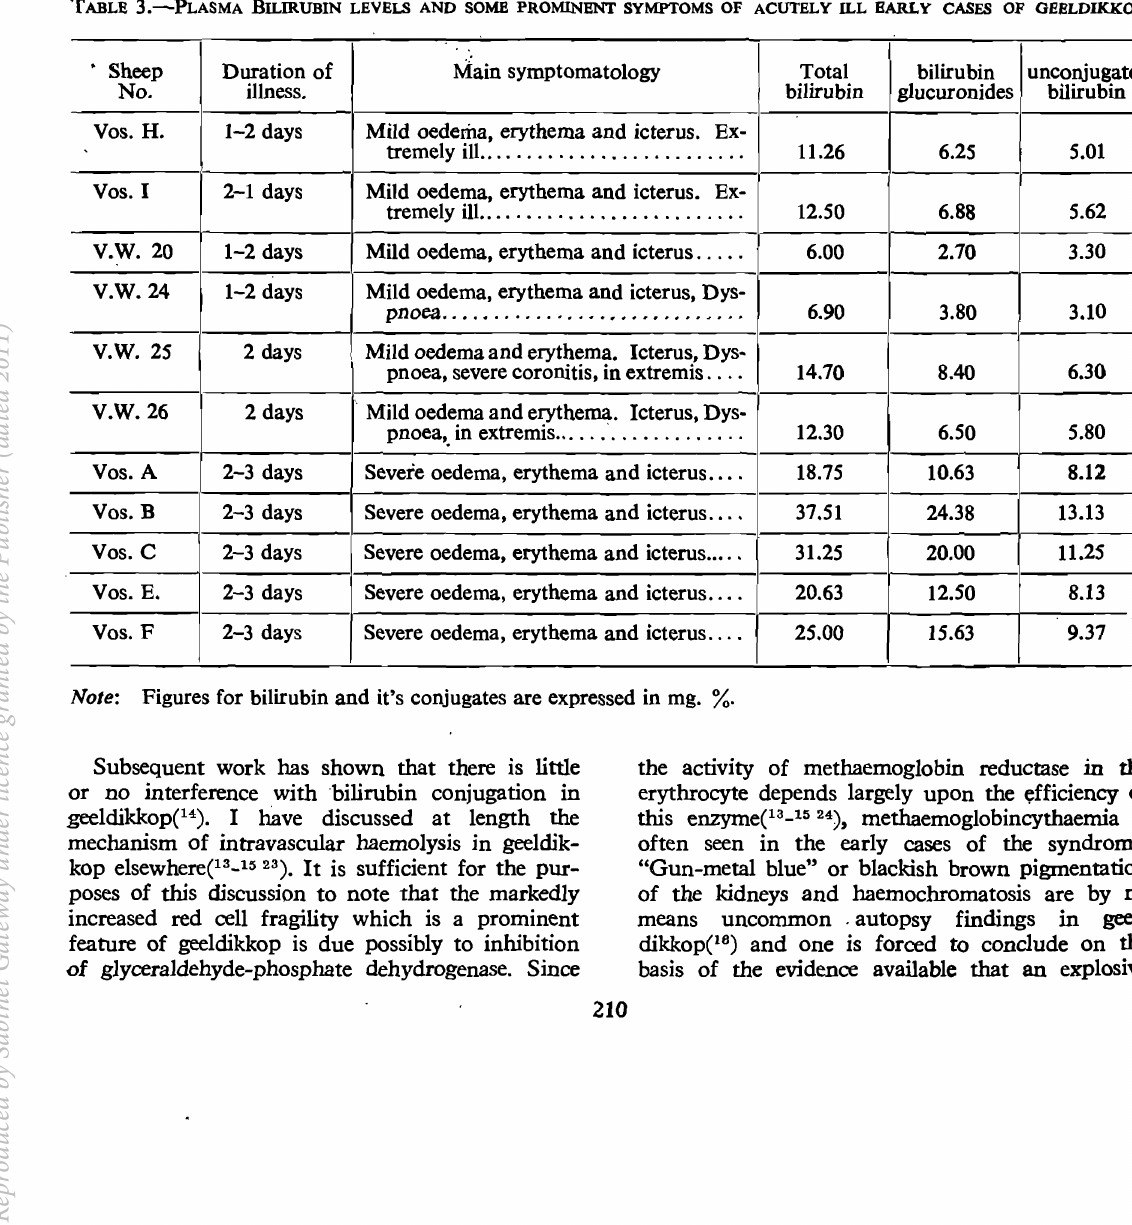
TABLE 3.-PLASMA BILIRUBIN LEVELS AND SOME PROMINENT SYMPTOMS OF ACUTELY ILL EARLY CASES OF